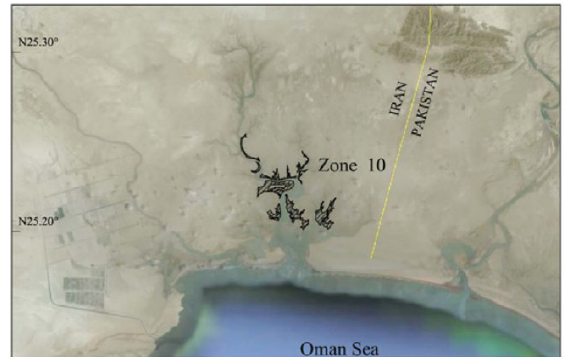
Figure 2: Govatr Bay mangorves forest; adopted from (Zahed et al., 2010)